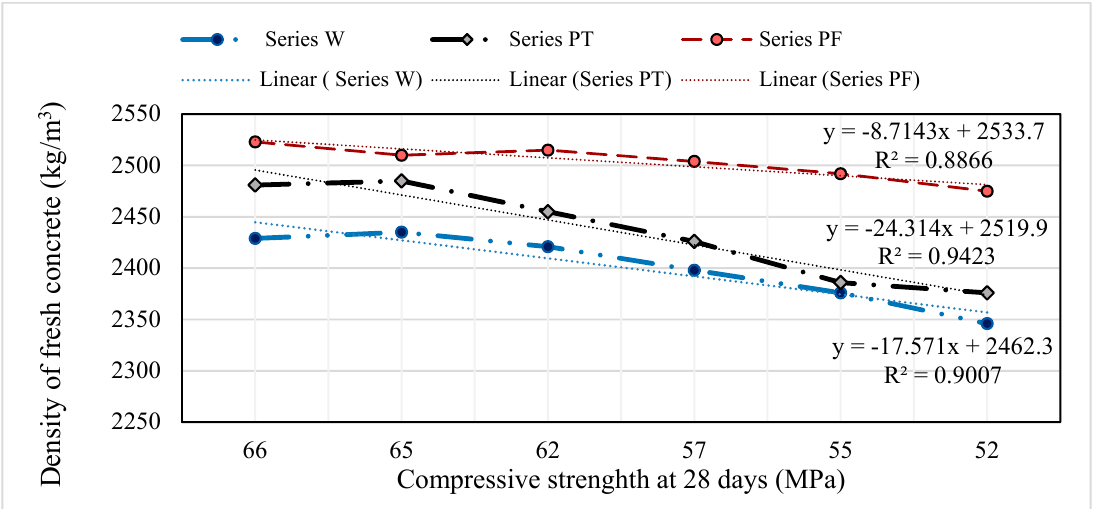
Figure 9. f cm of concrete mixes at: ( a ) 7 days; ( b ) 28 days; ( c ) 90 days; ( d ) 180 days.